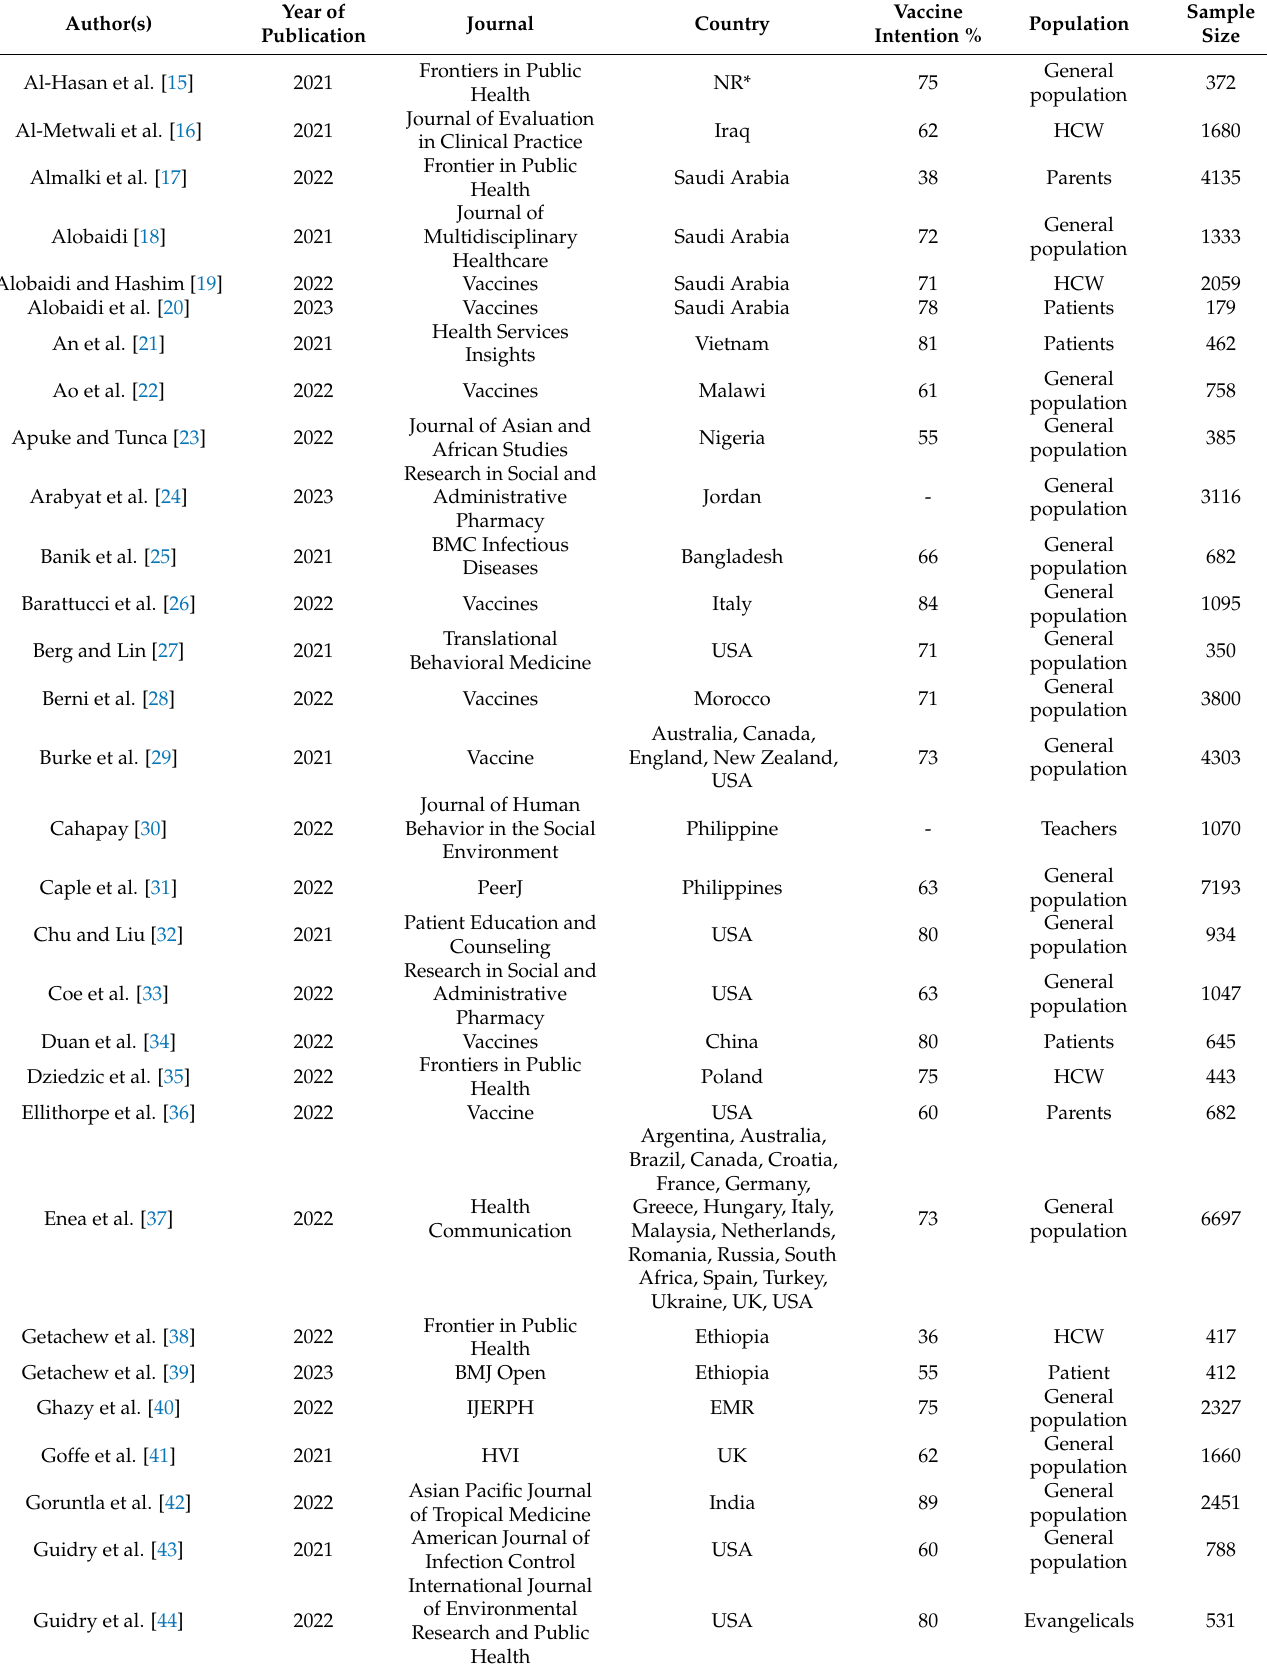
Table 1. Basic characteristics of the studies included in this systematic